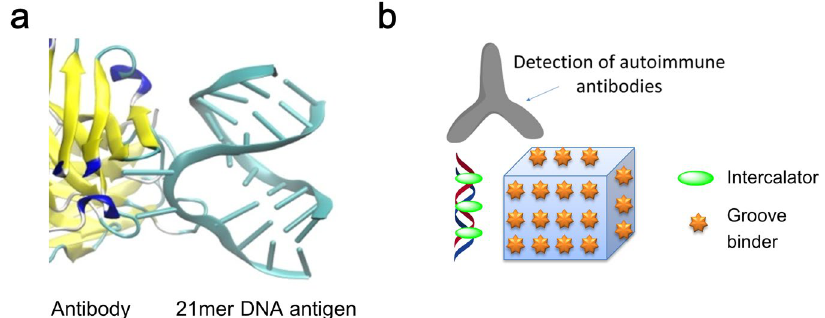
Figure 1. ( a ) Molecular model for the interaction between dsDNA and monoclonal autoimmune antibody ED- 10 9–11 ; ( b ) Two types of the synthetic antigens used in this work: short synthetic DNA and 3D DNA